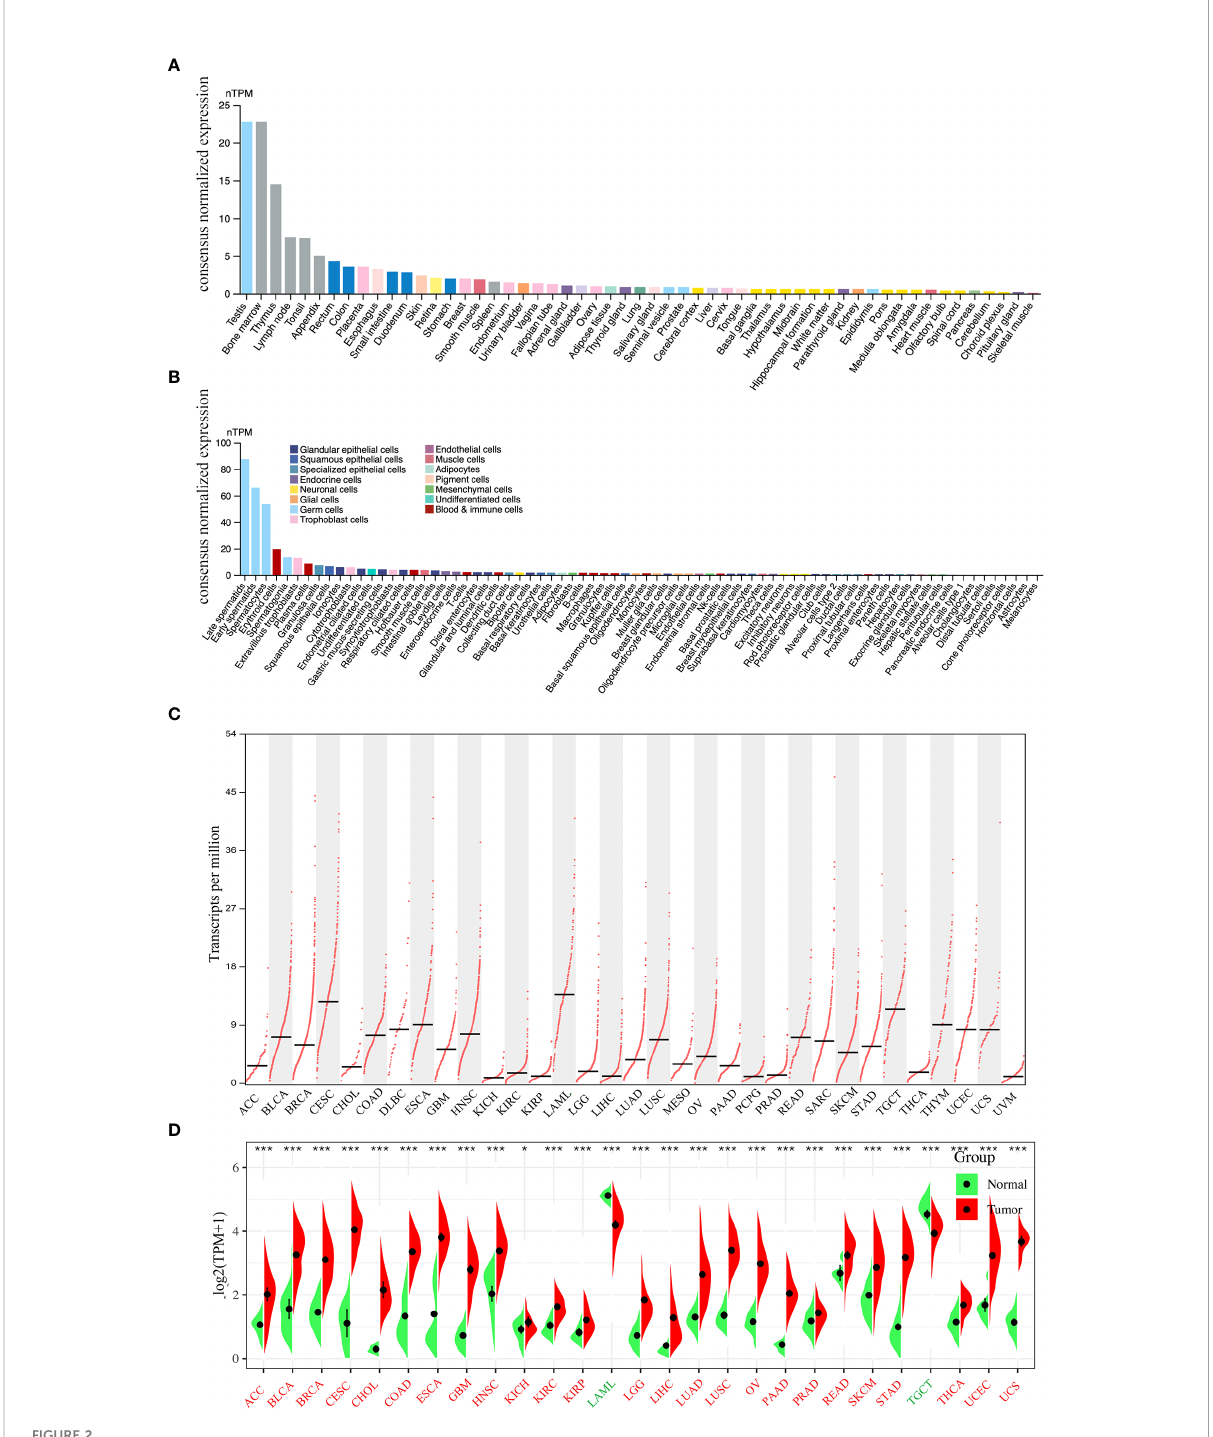
FIGURE 2 Expression levels of PLK4 mRNA in different tissues and cells. The expression status of the PLK4 mRNA in different normal tissues (A) and somatic cell types (B) were analyzed through Human Protein Atlas (HPA). (C) Based on the TCGA (The Cancer Genome Atlas) data, the expression levels of PLK4 mRNA in different cancer tissues were analyzed via GEPIA2. (D) The expression levels of PLK4 mRNA in tumors and normal tissues from TCGA and GTEx (The Genotype-Tissue Expression) databases were analyzed using SangerBox. * P < 0.05, *** P <